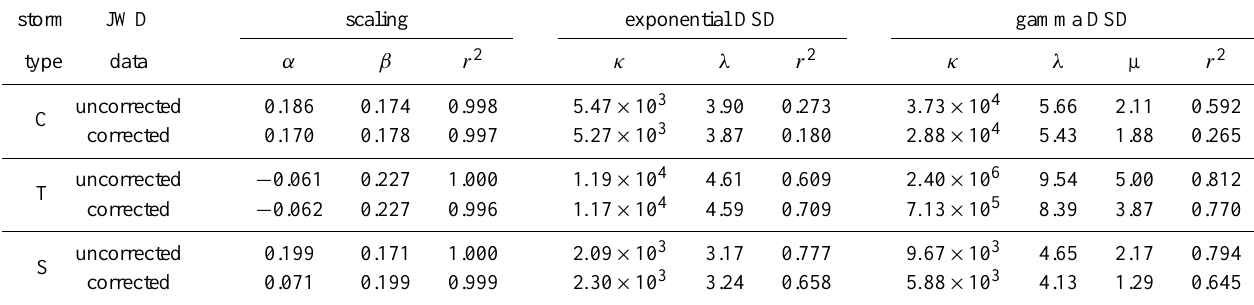
Table 2. Results of scaling analyses performed on the Goodwin Creek dataset for the three different regions within the event: convective (C); transition (T); and stratiform (S). Results are shown for corrected and uncorrected (Uijlenhoet et al., 2003) JWD